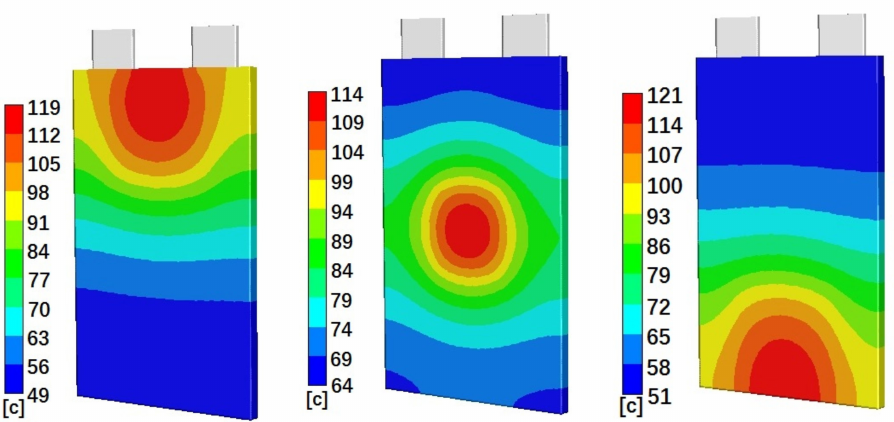
Figure 4. Simulated temperature distributions on the battery cell surface for Case 4 (left), Case 5 (middle), and Case 6 (right), at 40 min, 30 min, and 40 min after penetration started,